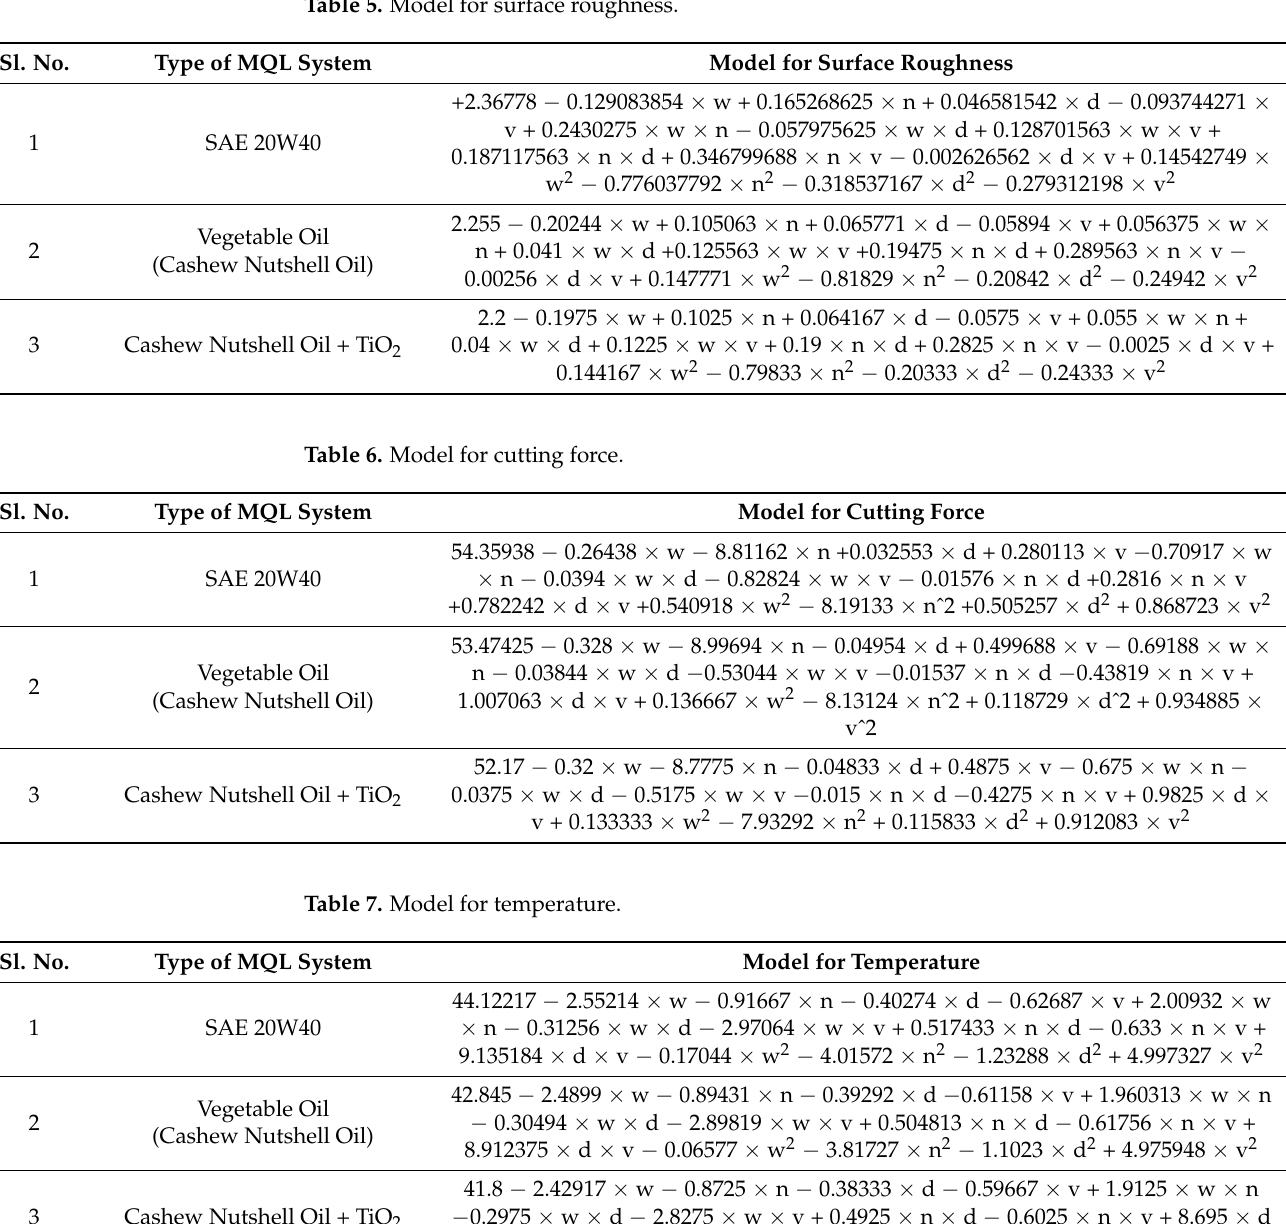
Table 5. Model for surface roughness.